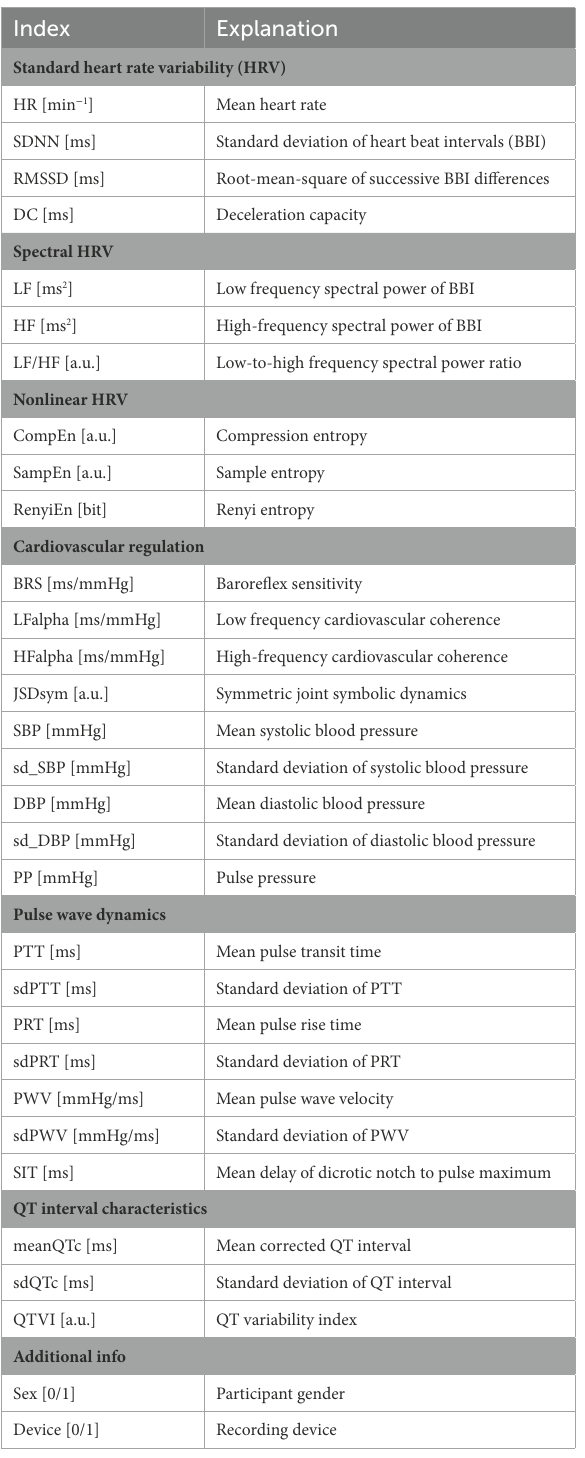
TABLE 2 Indices included in age